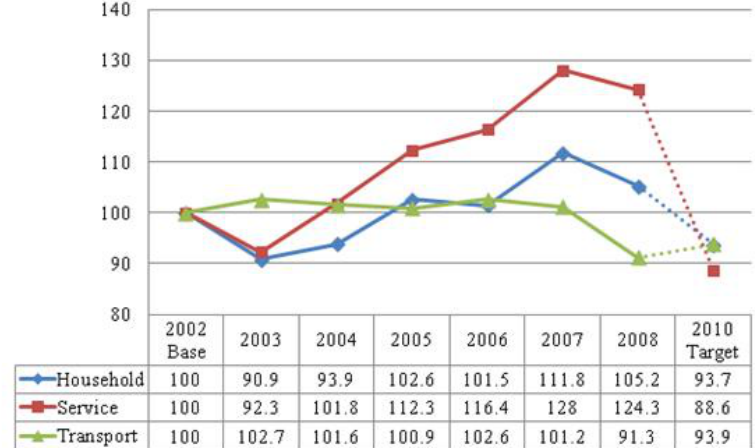
Figure 1. Changes in CO emissions from three targeted sectors in Oita Prefecture, with 2 2002 as the reference year